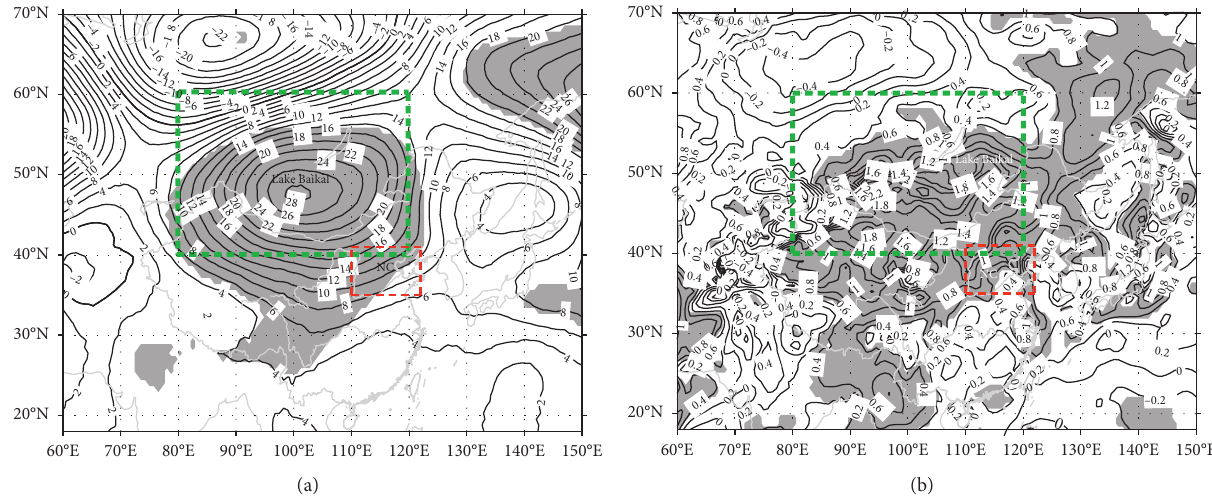
Figure 7: Same as Figure 5 but for (a) 500 hPa geopotential height (unit: gpm) and (b) SAT (unit: ° C).